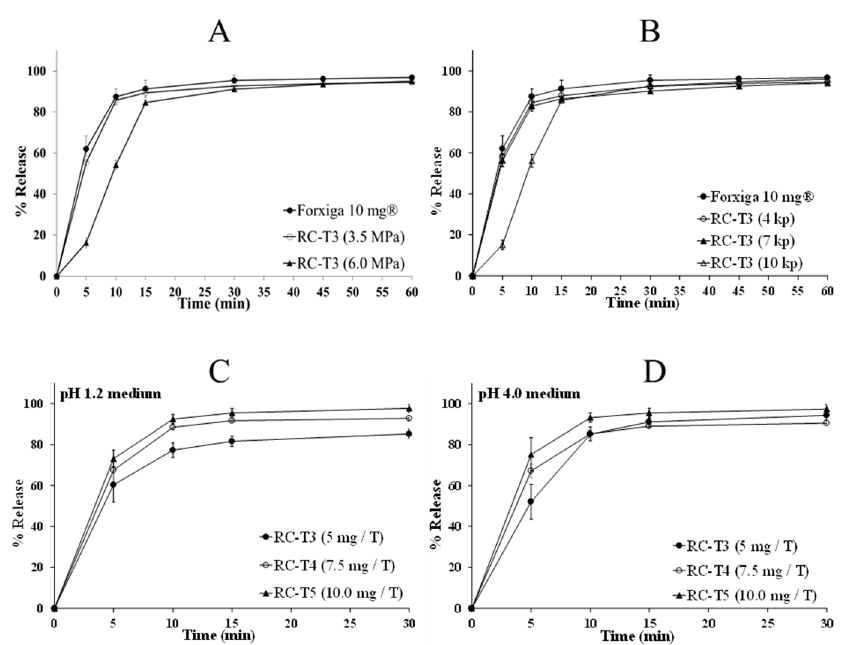
Figure 2. Effect of manufacturing parameters on the dapagliflozin (DAP) dissolution profiles. ( A ) Roller pressures (3.5 Mpa and 6.0 Mpa) with RC-T3 formulation with pH 1.2. ( B ) Tablet hardness (4 kp, 7 kp, and 10 kp) with RC-T3 formulation in pH 1.2, and Crospovidone contents (RC-T3, T4, T5) in ( C ) pH 1.2 and ( D ) pH 4.0. The experiment was conducted in USP Apparatus 1 at 50 rpm and in 900 mL dissolution media at 37.0 °C. Each value represents the mean ± standard deviation ( n = 6).